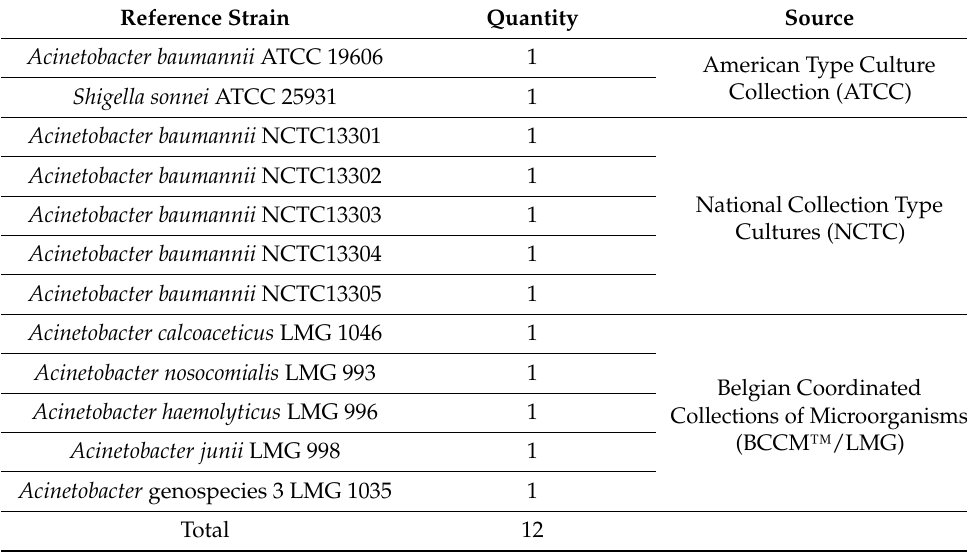
Table 1. List of reference strains used in this study. Reference